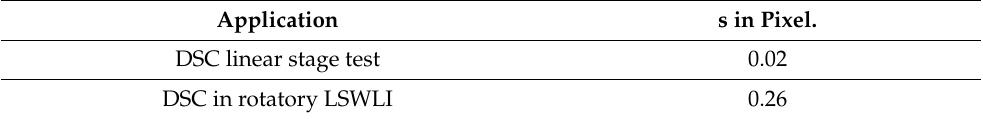
Table 1. Standard deviations of digital speckle correlation (DSC) displacement measurements obtained from the rotatory lateral scanning white light interferometry (LSWLI) measurement and from the reference measurement on the linear